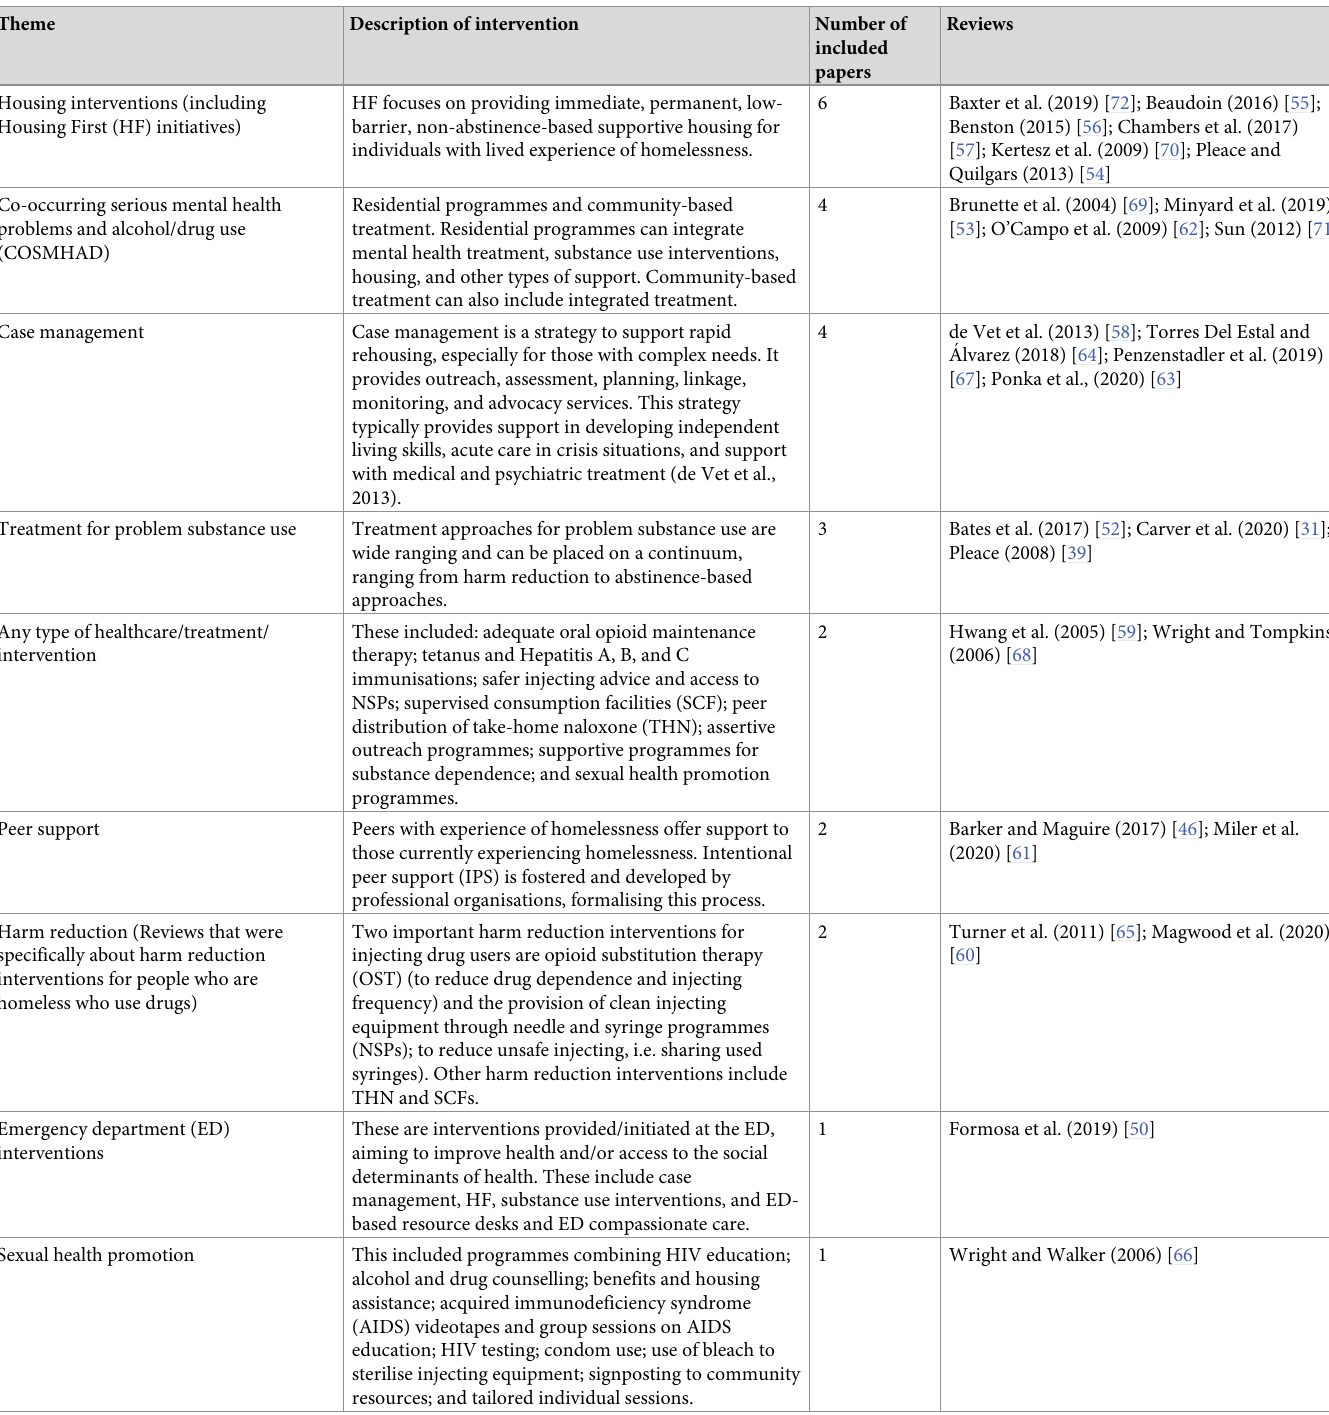
Table 3. Primary focus of included